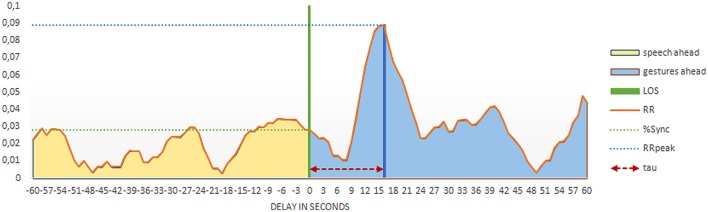
LOS (line of synchrony) profile plot of one child (boy, 55 months).